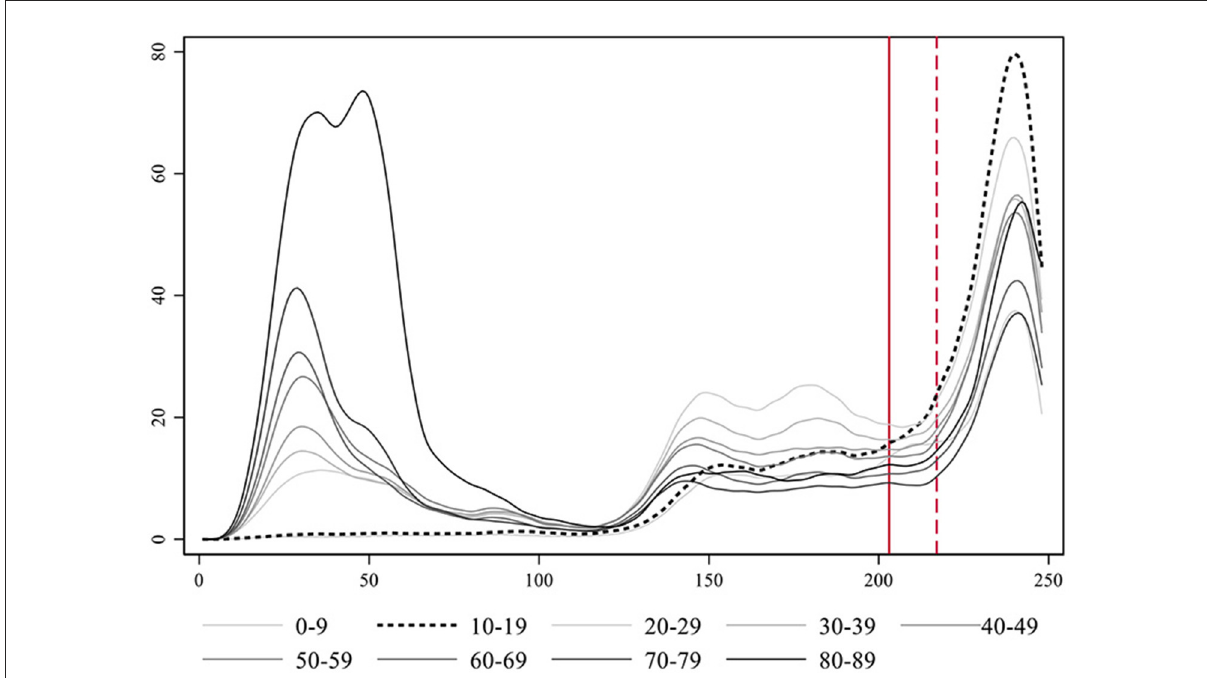
FIGURE5 Smoothed estimates using locally weighted regression of the evolution of the rate of COVID-19 cases per day in Catalonia by age-groups. Notice that the age-group 90 + is not represented for clarity purposes, due to its large incidence levels during the first wave.